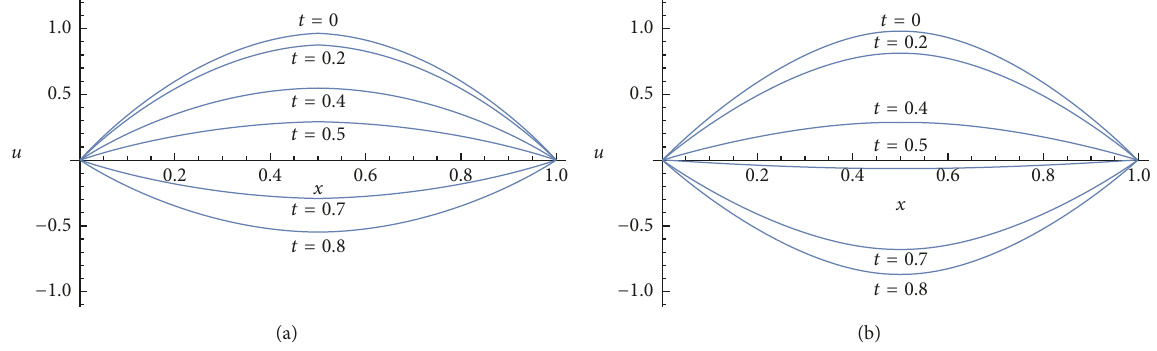
Figure 1: Vibrating power-law strings: 𝑛 = 0.2 (a) and 𝑛 = 0.5 (b) at 𝑡 = 0, 0.2, 0.4, 0.5, 0.7, 0.8